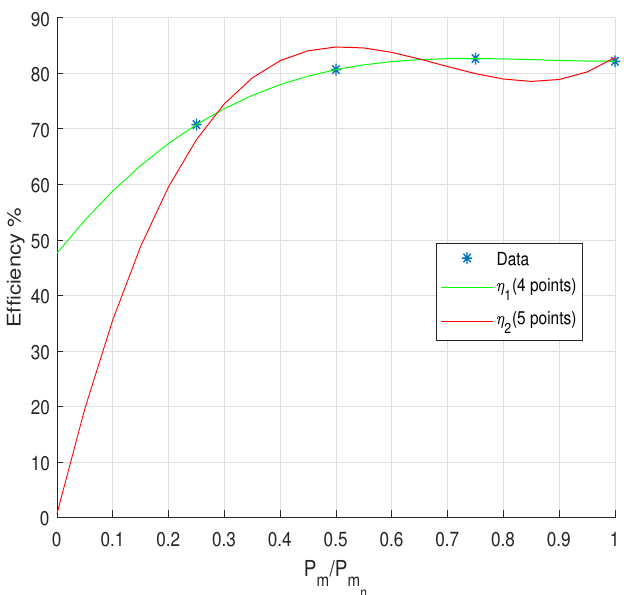
Figure 4. Polynomial Model of 3rd Order of efficiency (4 and 5